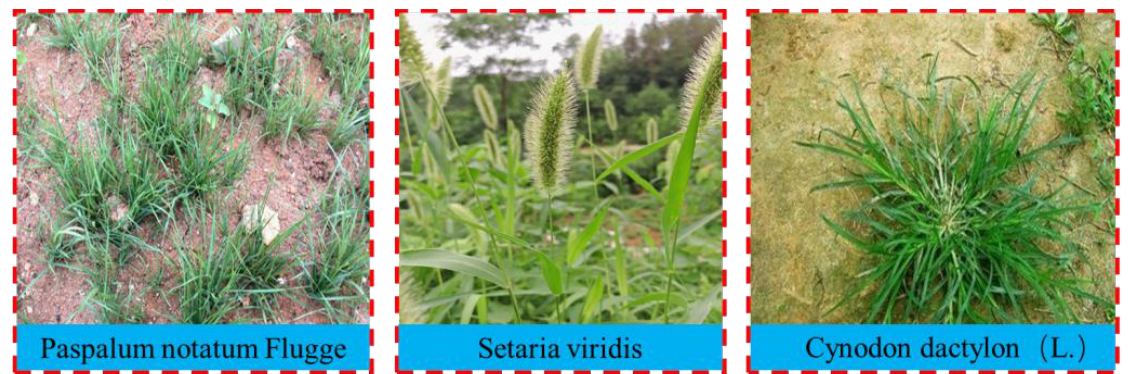
Figure 1. Study area.